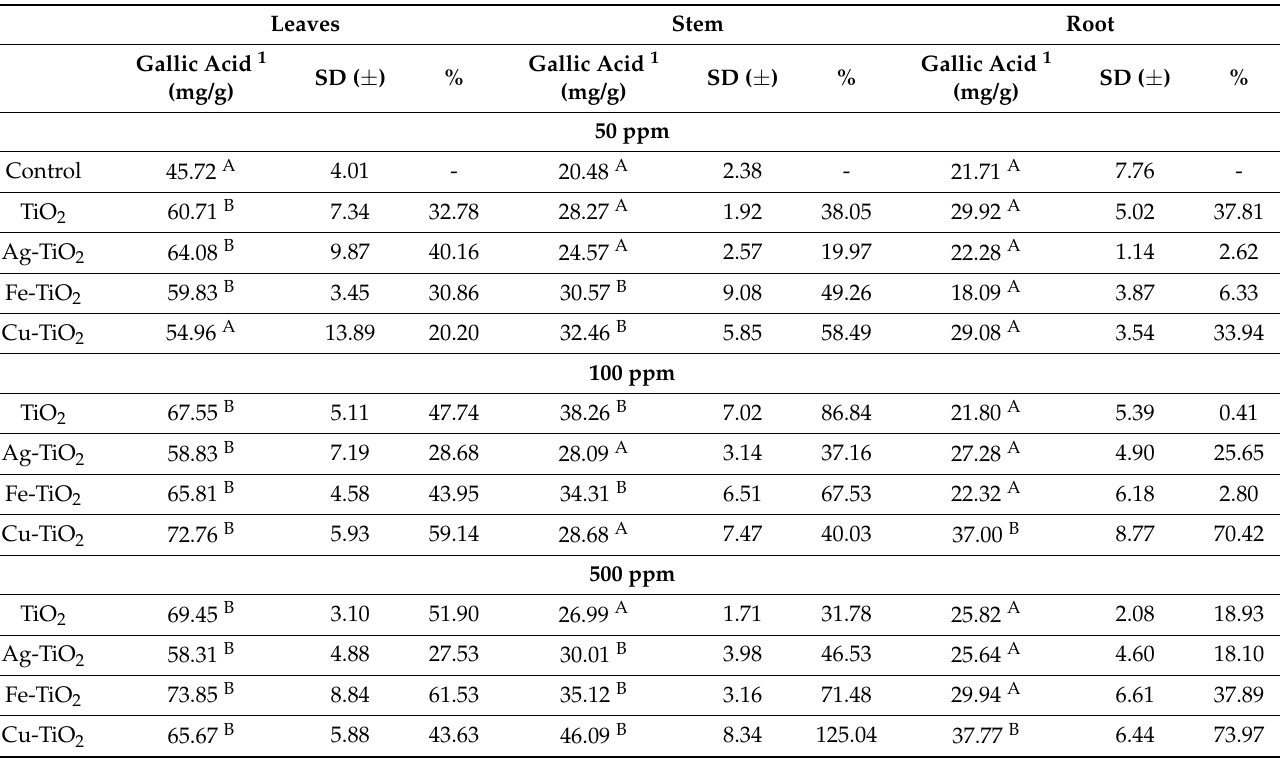
Table 3. Total phenol content in plants treated with Mw-SG